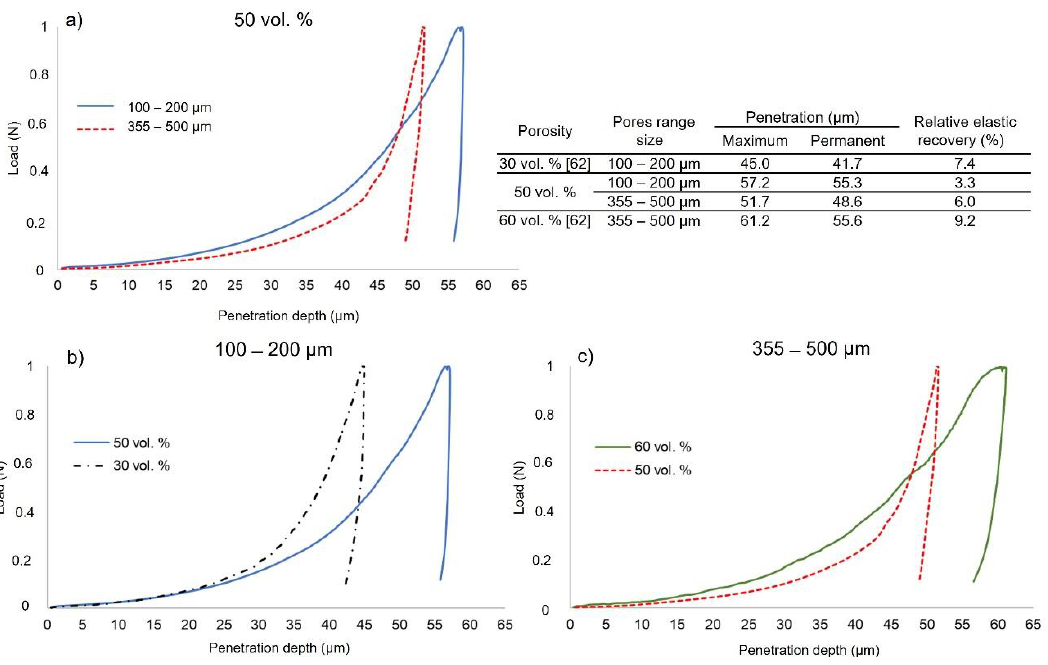
Figure 4. P-h curves of the coated porous c.p. Ti substrates ( a ) 50 vol.% for the two pores ’ range sizes, ( b ) 30 and 50 vol.% and 100 – 200 µm, and ( c ) 50 and 60 vol.% and 355 – 500 µm. Inset table: maximum penetration depth and relative elastic recovery for different percentages of porosity and pores range size.